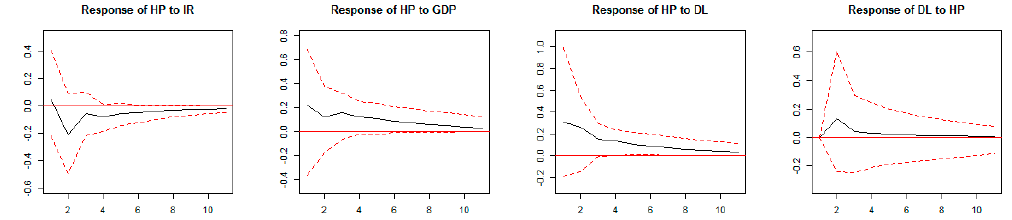
Figure 9. Estimation results of parameters in the TVP-VAR model (real estate development loans– housing prices). Notes: The figure shows sample auto-correlations ( top ), sample paths ( middle ), and posterior densities ( bottom ); in the top figures, the x -axis is the sample auto-correlation, and the y -